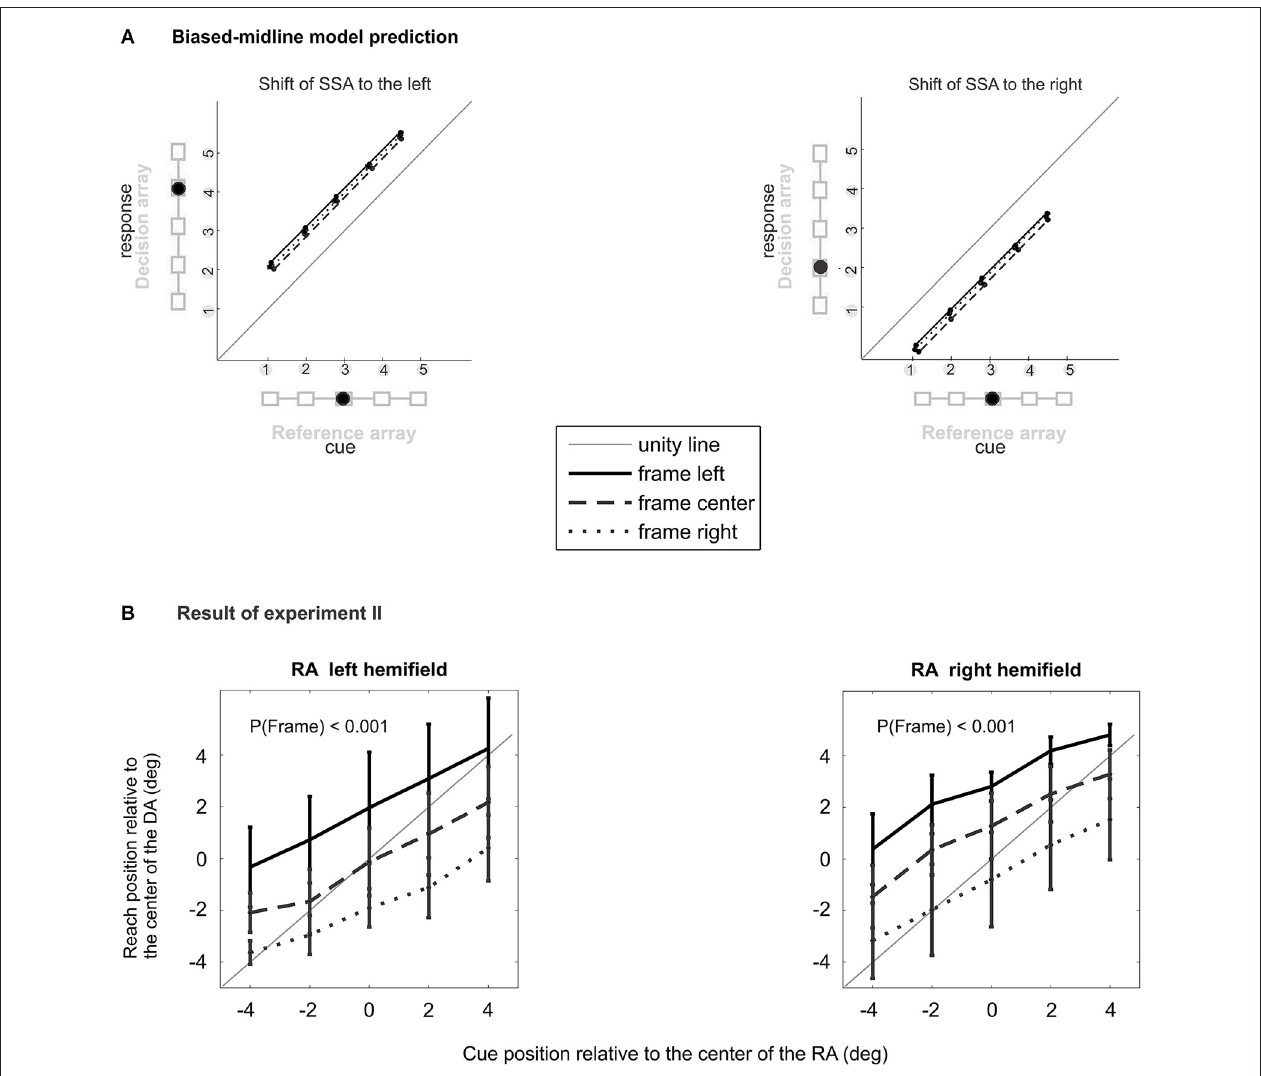
endpoint (HRDA) of 10 subjects separately for two positions of the RA indicates that an allocentric shift of the frame (shift relative to the RA) explains the mislocalization best. There was a significant main effect of frame and target location and no significant (frame × target)